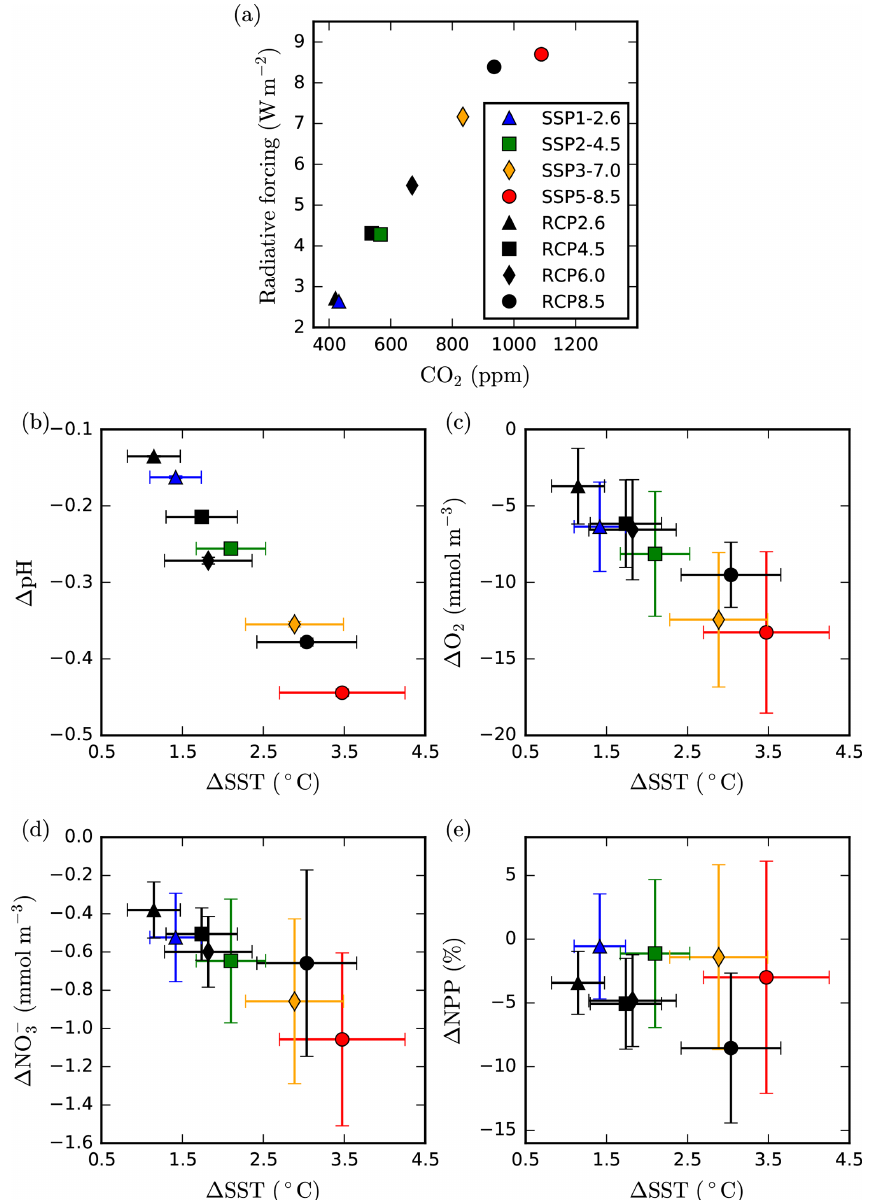
Figure 6. Comparison between CMIP6 and CMIP5 end-of-century changes in upper-ocean impact drivers. (a) Atmospheric CO 2 concen- tration and radiative forcing derived from the MAGICC6 model in year 2100 for the CMIP6 SSPs and CMIP5 RCPs. (b–e) Global mean anomalies of (b) surface ocean pH, (c) subsurface dissolved O 2 concentration (averaged between 100 and 600m ; mmolm − 3 ), (d) NO − concentration (averaged between 0 and 100m ; mmolm − 3 ), and (e) integrated net primary production (%) against anomalies of sea surface temperature ( ◦ C). Anomalies are 2080–2099 mean values relative to the 1870–1899 baseline period. Error bars represent the inter-model